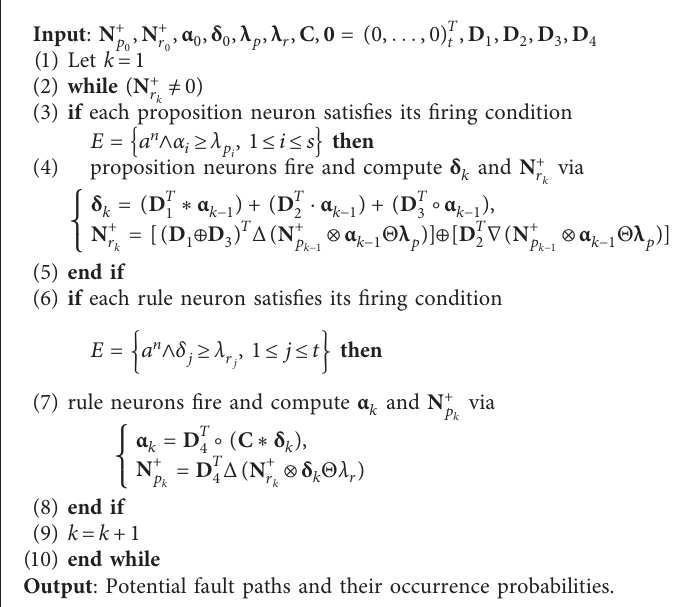
A LGORITHM 2: Forward fault prediction reasoning